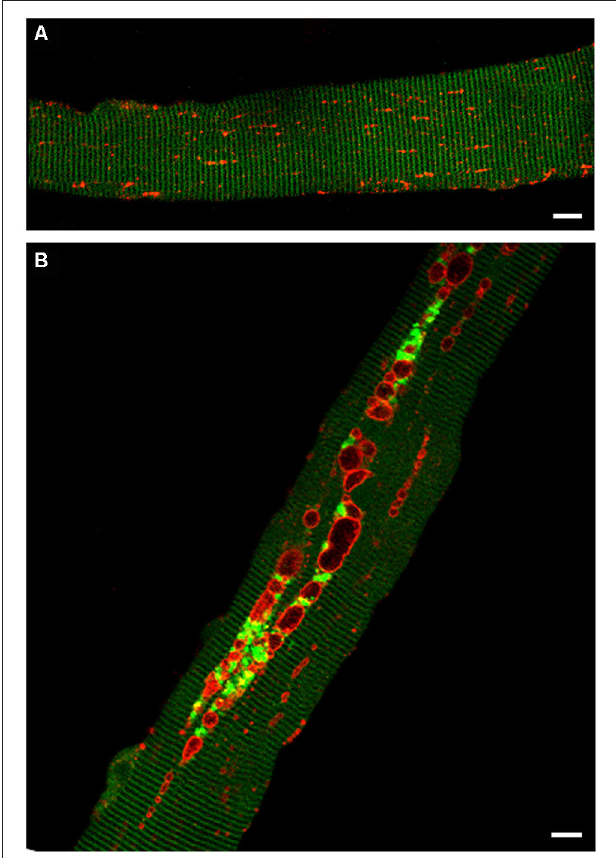
FIGURE 3 | Confocal microscopy images of fibers from GFP-LC3:WT (A) and GFP-LC3:GAA-KO (B) mice. In these strains autophagosomes are labeled with green fluorescent protein. Accumulation of autophagosomes (green) can be seen in live unstained muscle fibers derived from GAA-KO, but not from WT mice. Muscle was transfected in vivo by electroporation with mCherry-LAMP1 to visualize lysosomes (red); fibers were isolated 6 days after the procedure. (A) Autophagosomes are not detectable in the control muscle. (B) This still image shows autophagic buildup in the core of a fiber from the diseased muscle. Time-lapse microscopy of mCherry-LAMP1 transfected fibers demonstrated that there is little, if any, fusion between lysosomes and autophagosomes in the areas of autophagic buildup. Bar: 10 µ